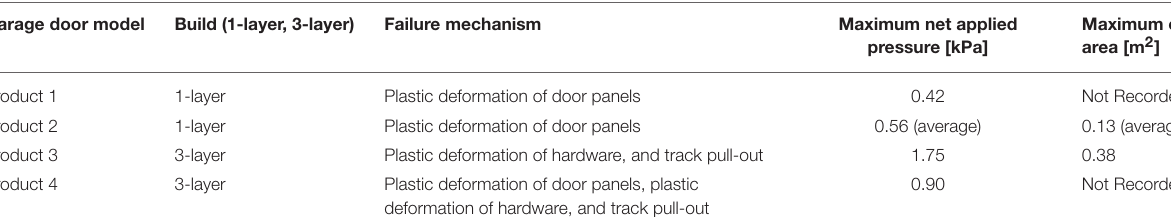
TABLE 2 | Comparison of test results for garage doors.